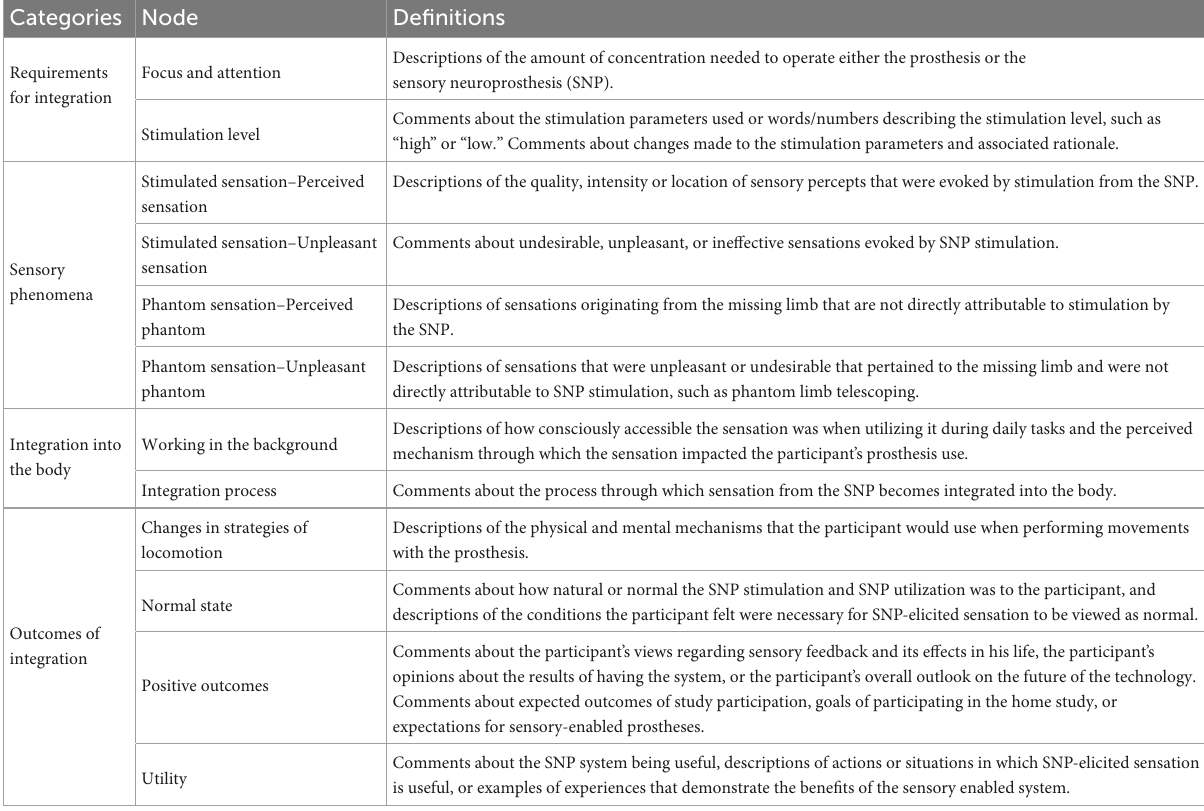
TABLE 1 Coding structure and definitions for qualitative